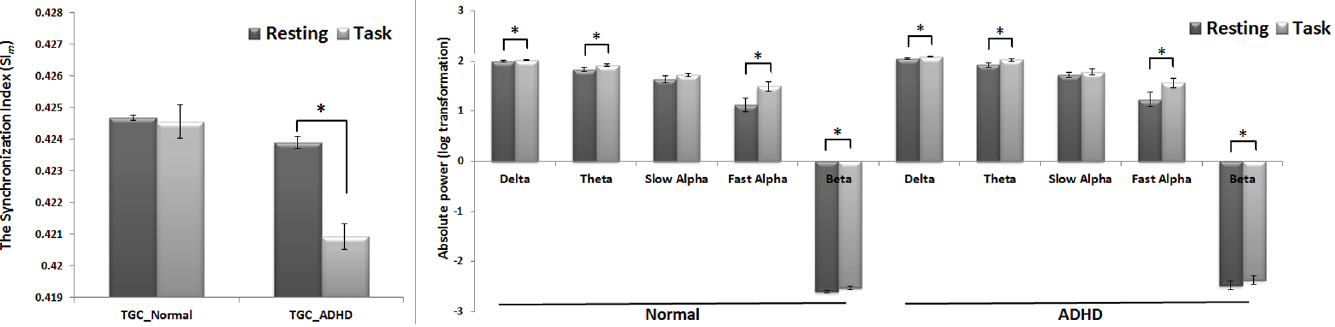
Fig 1. Cross-frequency phase-amplitude coupling and power-spectrum analysis during a mental arithmetic task. The data are reported as the mean ± the standard error of the mean. ADHD, Attention Deficit/Hyperactivity Disorder; TGC, theta-gamma